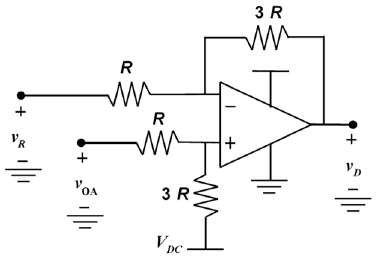
Figure 3. Schematic of the difference amplifier.